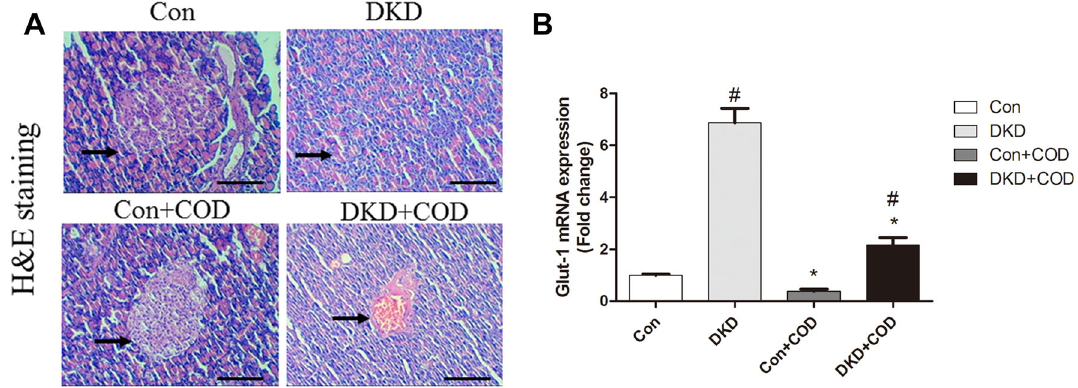
Fig. 4 Effect of COD on pancreas and Glut-1 expression. The photomicrographs of H&E-stained sections ( a ) were obtained for the four groups on day 30 after COD treatment. Scale bar: 600 l m Con group; ** p \ 0.01 vs. COD treatment (n =